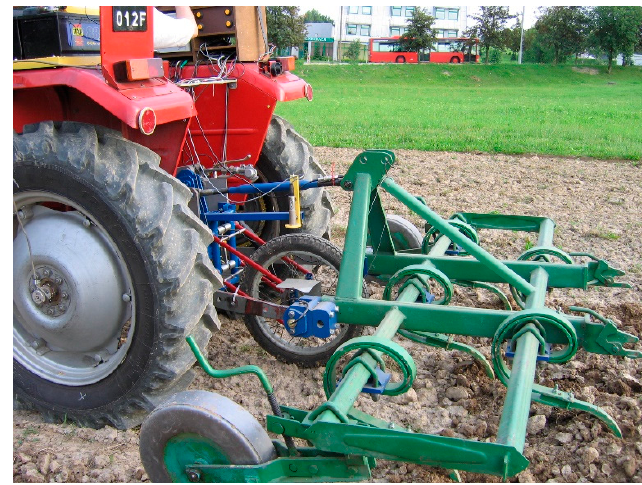
Figure 1. A view of the machine unit during field tests. The total weight of the tractor unit was 2375 kg. The load on the rear wheels was 1530 kg, and the remaining part of the machine unit weight was on the front axle.